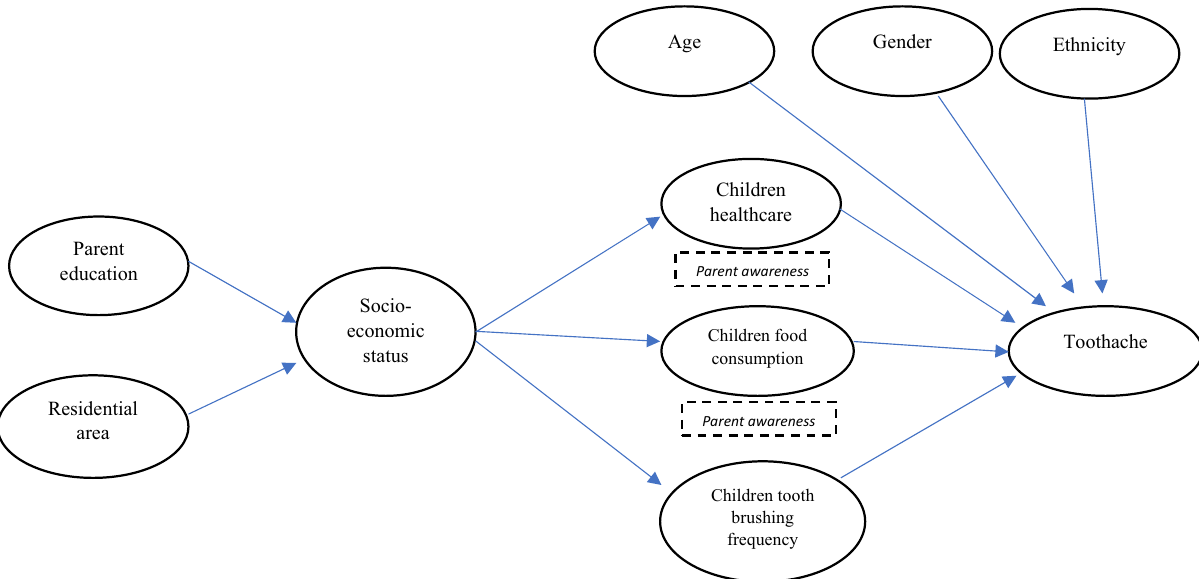
Figure 1. Structural equation model hypothesis of toothache and its